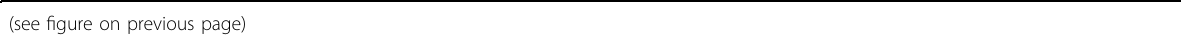
Fig. 3 ASK1 functions as a key mediator of TGF- β downregulation-induced cell death triggered by non-canonical signaling Akt inactivation a ASK1 mediates TGF- β -induced cell death via p38/JNK activation. A375 and HPAC cells were infected with adenovirus expressing shTGF- β 1 or - β 2 (100 MOI) and subsequently transfected with siASK1. siASK1 transfection was based on the siRNA transfection protocol (Santa